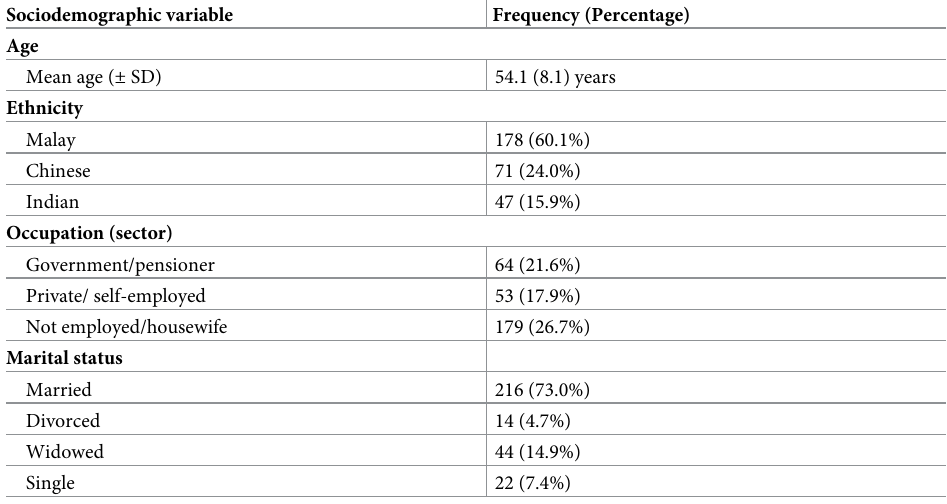
eligibility criteria of the available mammogram screening programs. Of the total number of respondents, 48 were diagnosed with breast cancer before the age of 40 years and thus were not in the age group for mammogram screening. They were then excluded from the subsequent analysis. The sociodemographic characteristics of the remaining 296 respondents are in Table 2. Among these respondents, only eleven (3.6%) claimed to have undergone mammogram screening on their own accord prior to being diagnosed with breast cancer. The frequency of mammogram screening done, time lapse between the mammogram screening and diagnosis; or the respondents’ perception on mammogram screening were not ascertained as these con- stituted another aspect of access (i.e. acceptability) which was beyond the scope of this study. The stage and status of mammogram screening for the respondents aged 40 years and more are summarized in Table 3. For the respondents aged 40 years and above who had undergone mammogram screening, the travel distance and travel expenditure were calculated. The findings are summarized in Table 4. Table 2. Sociodemographic characteristics of respondents aged 40 years and more (n =